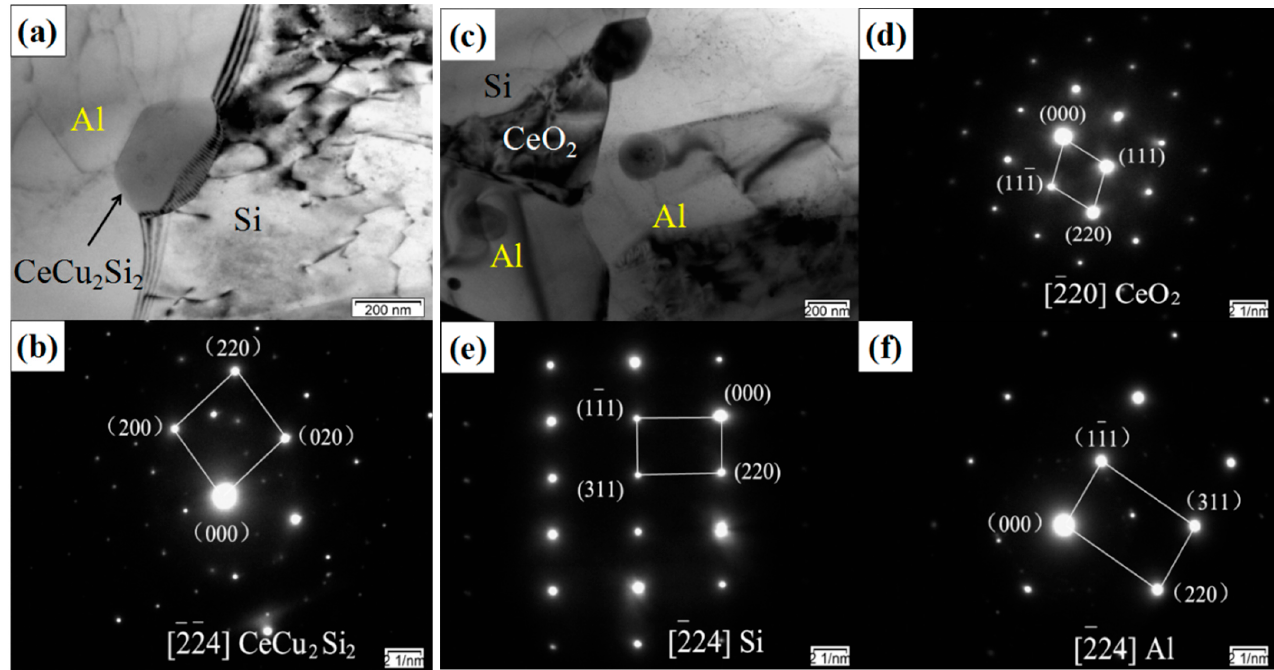
Figure 6. TEM images of SiCp/Al-Si composites with 0.2 vol% CeO 2 content: ( a ) the precipitated phase CeCu 2 Si 2 ; ( b ) diffraction patterns of CeCu 2 Si 2 ; ( c ) CeO 2 -Si and CeO 2 -Al interface; ( d ) diffraction patterns of CeO 2 ; ( e ) diffraction patterns of the precipitated Si; ( f ) diffraction patterns of Al.